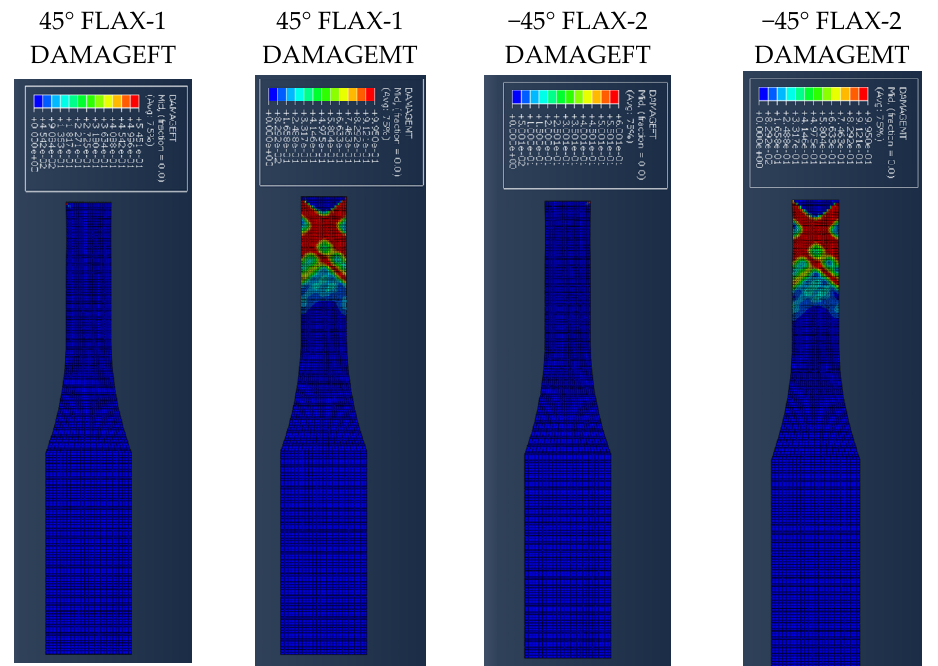
Figure 15. Damage evolution of each top composite layer of specimen C at 1 mm displacement.